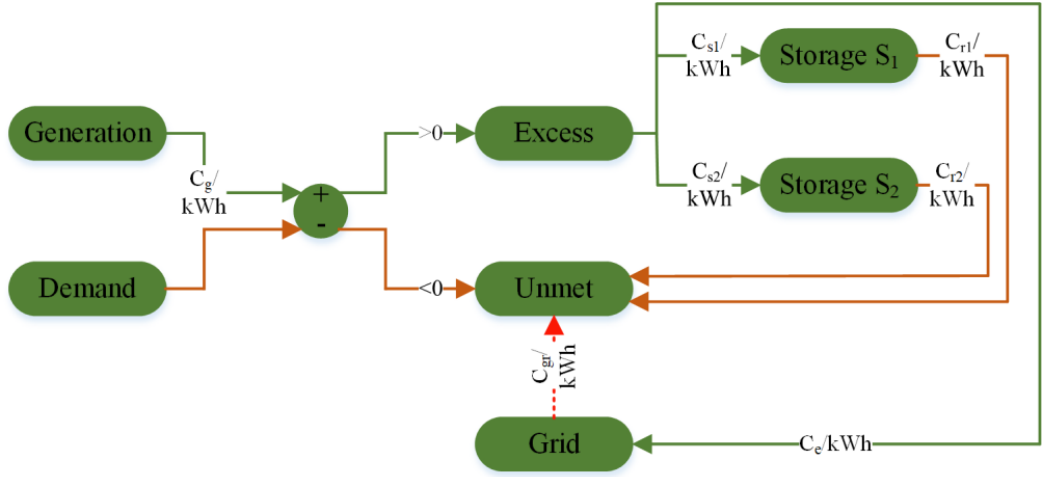
Figure 4 . Implementation of two batteries with the PV system and utility grid .